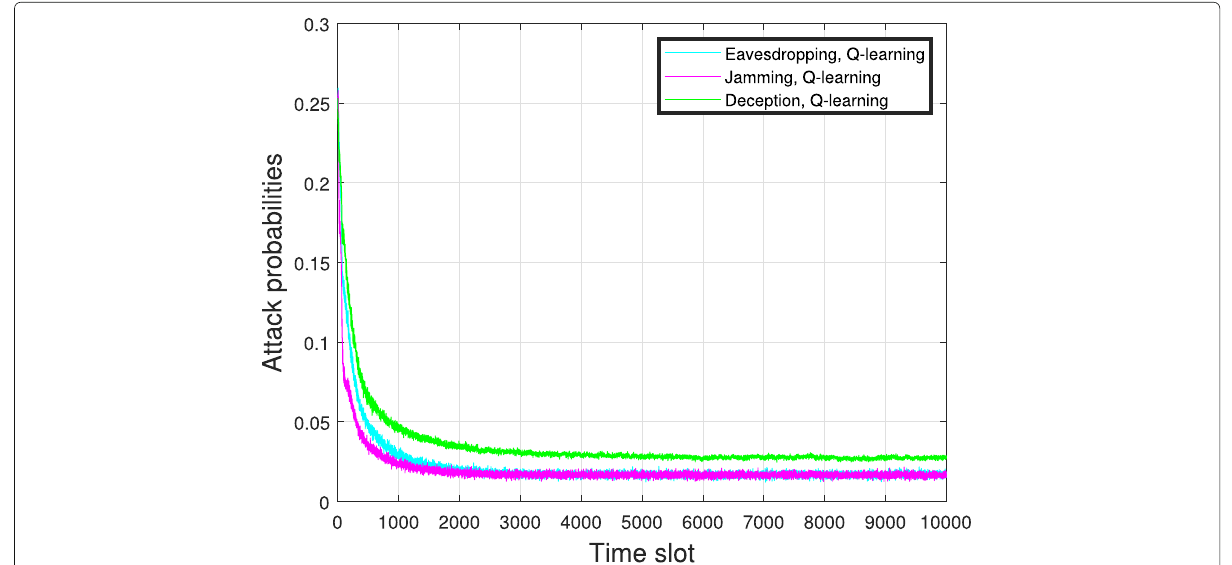
Fig. 6 The average attack probabilities of the power allocation algorithm with { ν 2 , μ 2 , λ 2 } = { 0.9,0.3,2